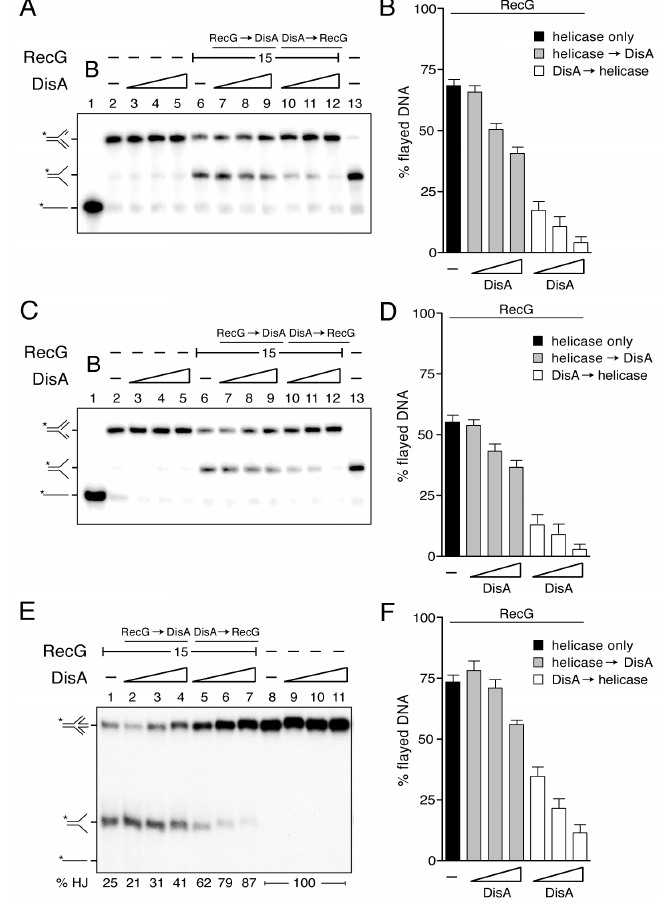
Figure 3. DisA inhibits RecG-mediated fork reversal and HJ regression. ( A , C , E ) [ γ 32 P] forked-Lead ( A ), [ γ 32 P] forked-Lag DNA ( C ), or [ γ 32 P] HJ-J4 DNA (0.1 nM) ( E ) was pre-incubated with increasing DisA concentrations (doubling from 12–48 nM) or a fixed amount of RecG (15 nM) in buffer B containing 10 mM MgCl 2 (5 min at 37 °C). Then, the second protein (variable DisA [RecG → DisA], a constant amount of RecG [DisA → RecG] or no protein) and 5 mM ATP were added and the reaction was further incubated for 15 min at 37 °C. The reaction was stopped, deproteinized and separated by 6% native PAGE. Gels were dried and visualized by phosphor imaging. -, no protein added; B, boiled product. ( B , D , F ) The relative amount of flayed DNA product in three independent experiments such as those shown in A, C and E was quantified, and the mean ± SD are represented. The radiolabeled strand is indicated with an asterisk.